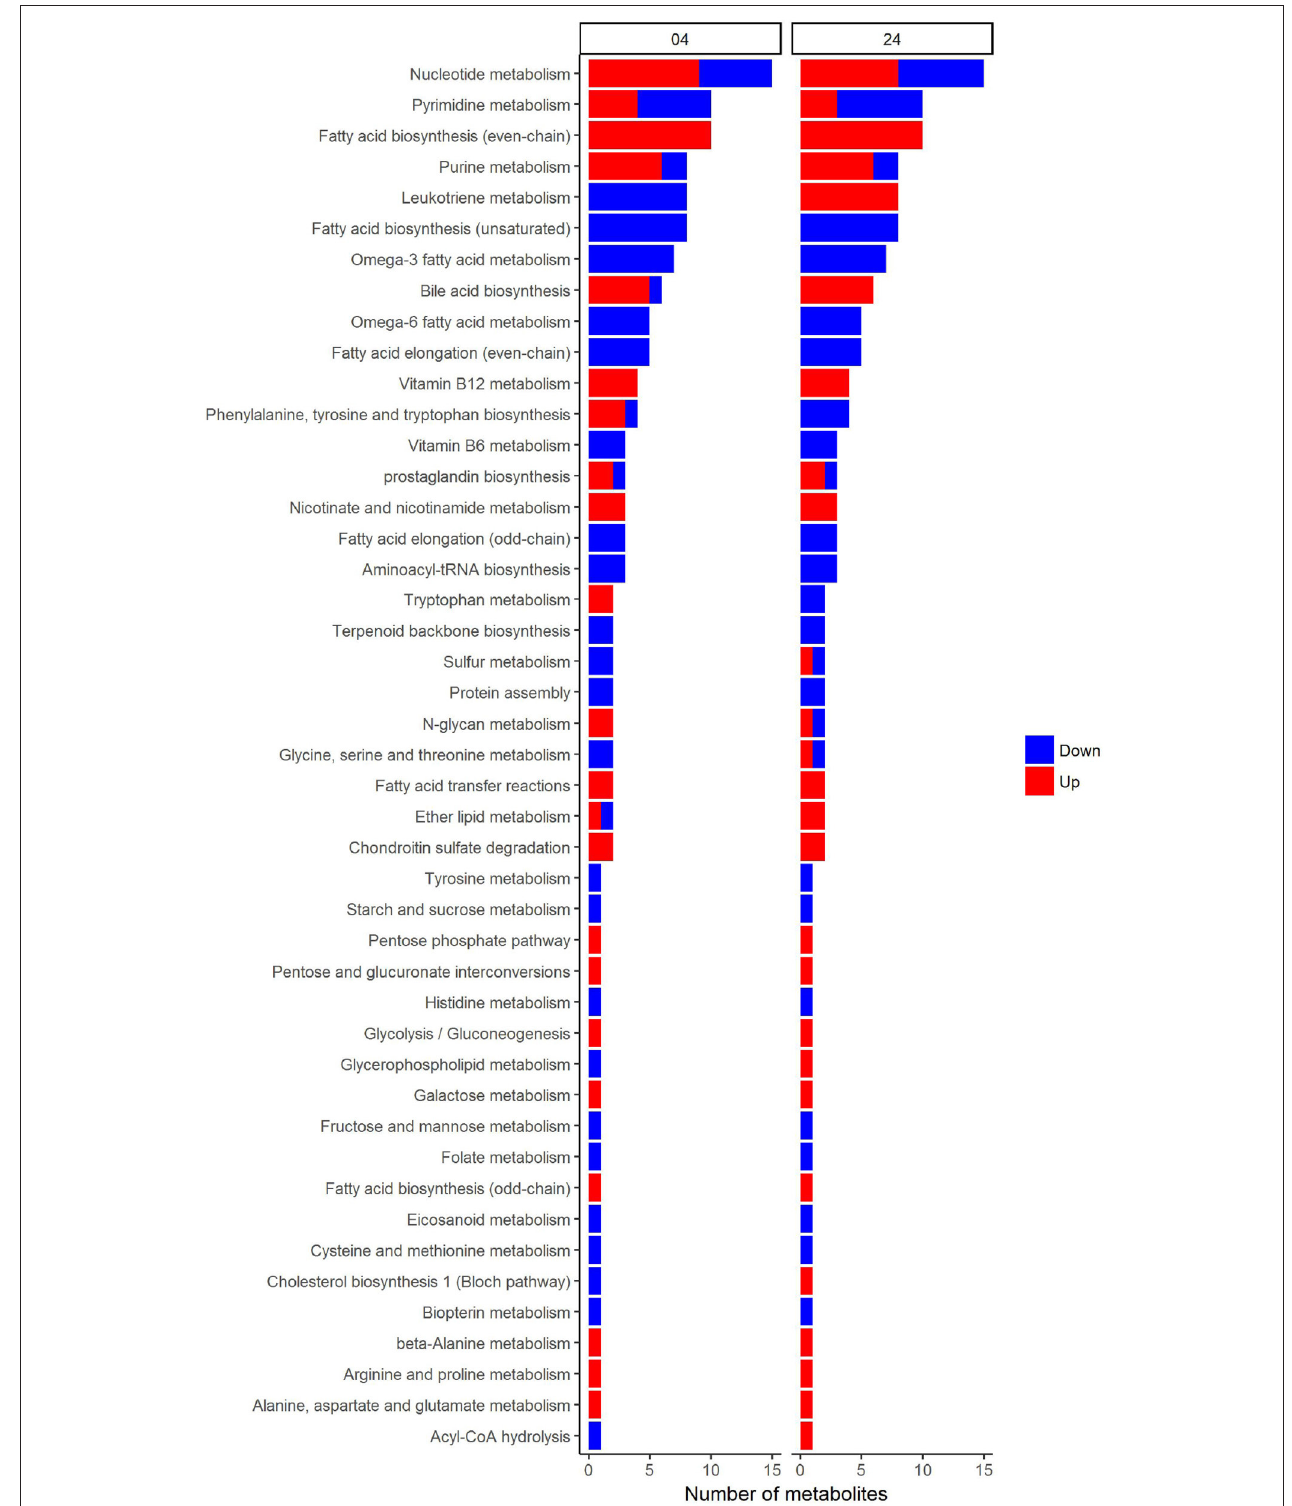
FIGURE 8 | Reporter metabolites that discriminate Candida -stimulated PBMCs from Borrelia , LPS, and MTB-stimulated PBMCs at 4 and 24 h. These reporter metabolites were grouped based on their associated subsystems in HMR2. Blue denotes significant down-regulation. Red denotes significant up-regulation.